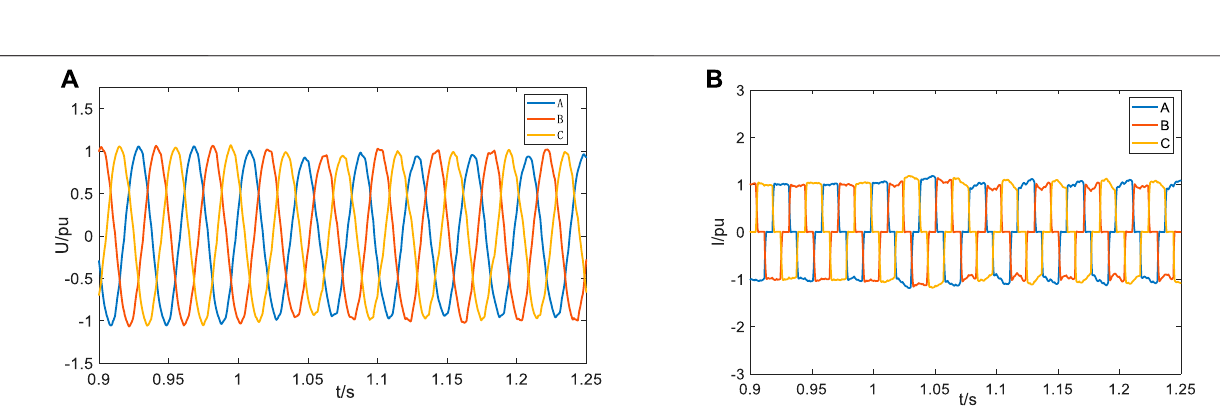
Frontiers in Energy Research |